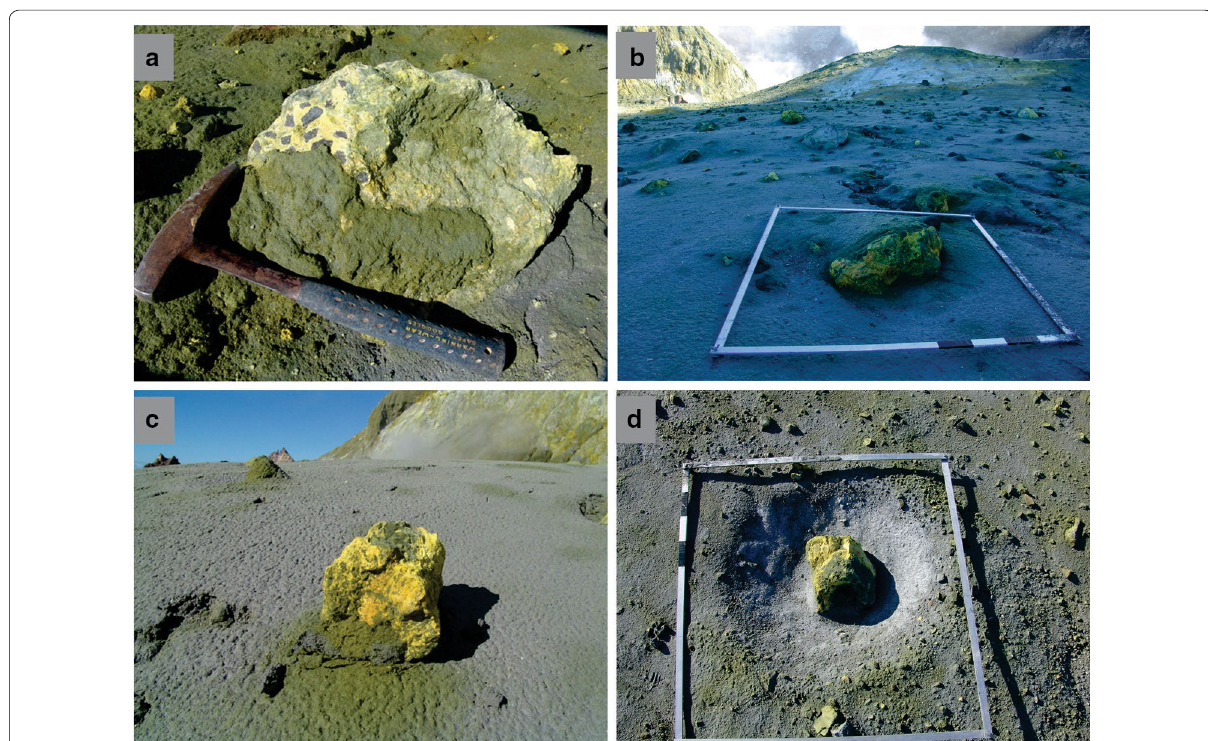
Fig. 8 A collection of ballistic types seen in the field. a An intensely altered breccia block is partially covered by the waning stages of the pyroclastic surge. b A near complete covering by the near-end stages of the surge blankets the breccia ballistic. c A solitary hydrothermally altered ballistic that has no clear sign of a ballistic crater, presumably due to crater infilling and/or near simultaneous ejection of ballistics and surge. d A clear ballistic impact crater within ~ 130 m of the inner crater